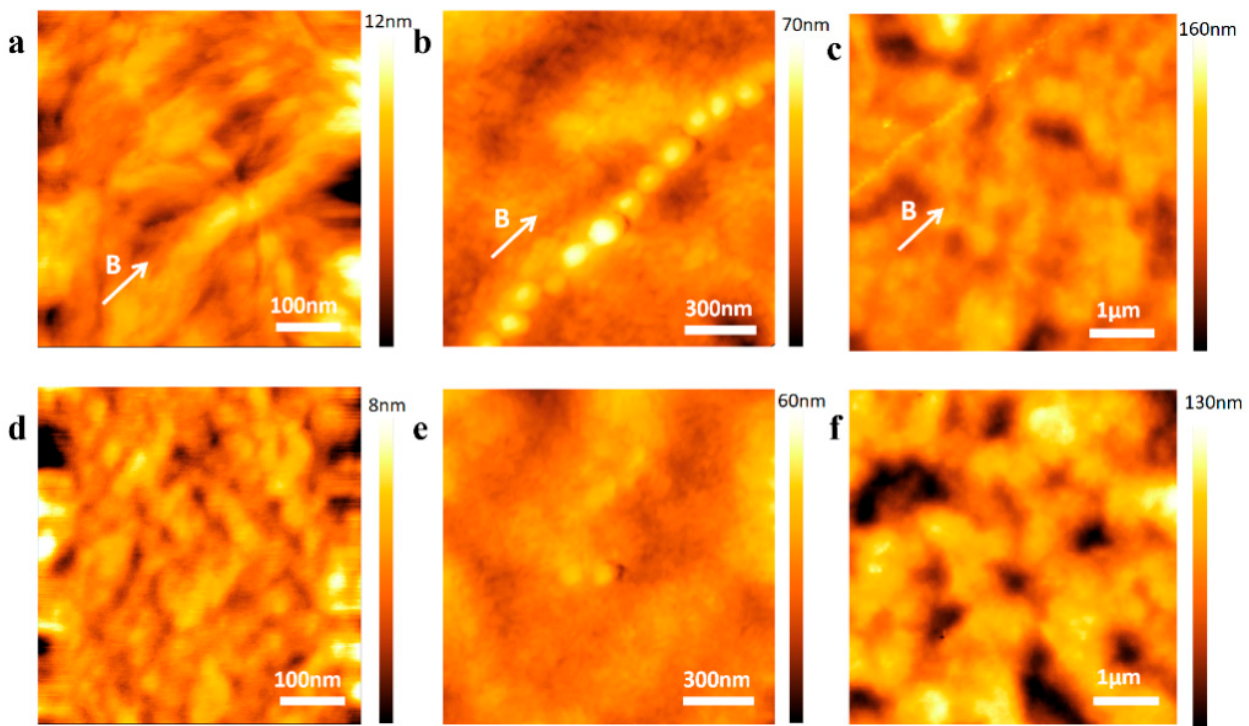
Figure 3. Tapping-mode AFM images of the Fe 3 O 4 @C/PBTTT composite films cast with ( a – c ) and without magnetic field ( d – f ). The white arrows denote the magnetic field direction.